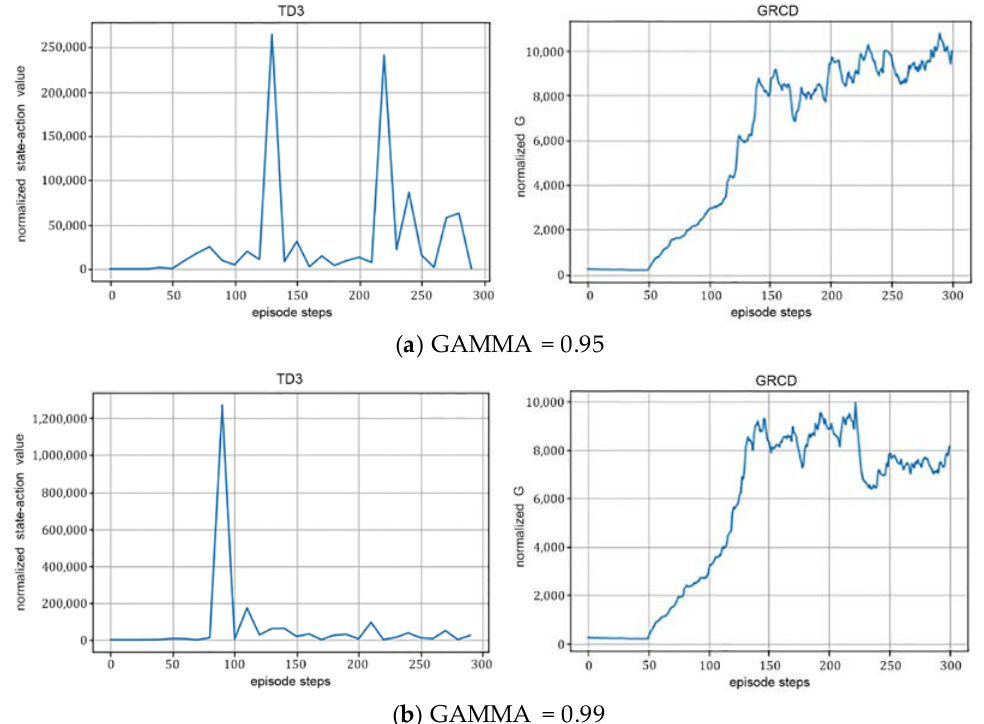
Figure 7. Effect of different discount rates on algorithm performance with N = 36, Explore_steps = 5000 and Hidden_dim = 128.